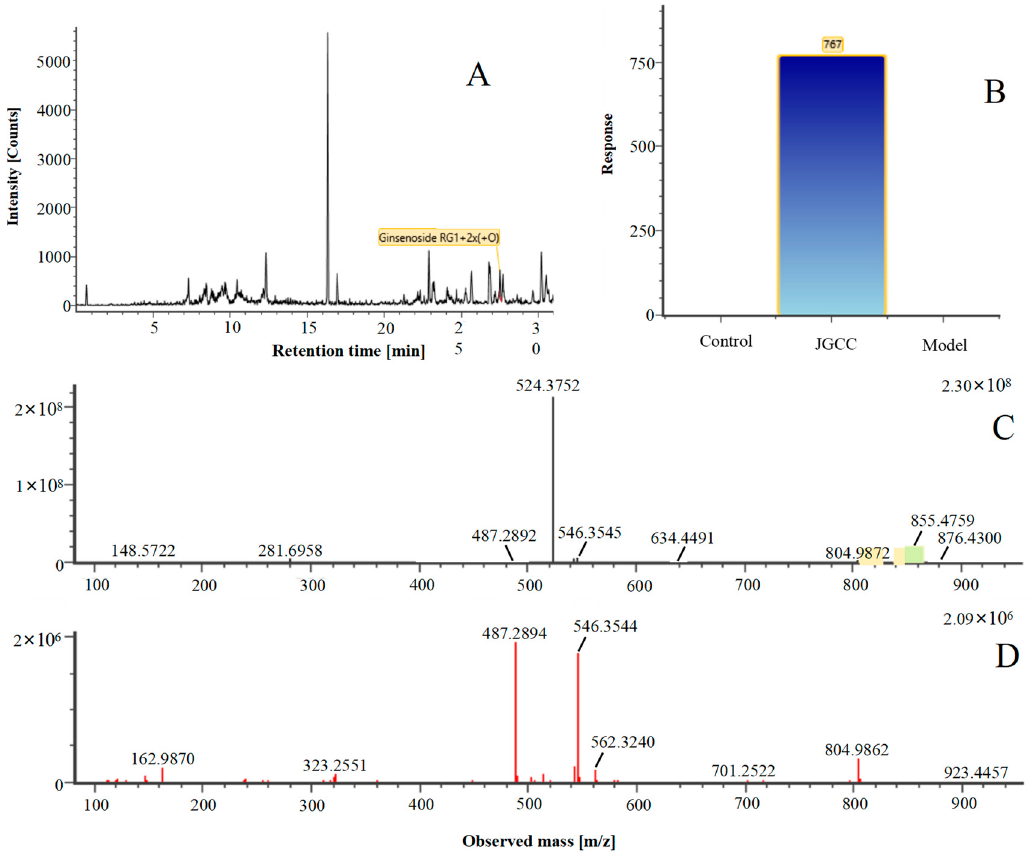
Figure 6. The characterization and identification of the blood component metabolite M 21 in JGCC based on the UNIFI data processing platform. ( A ): chromatographic peak extraction diagram of the metabolite M 21 from Ginsenoside Rg 1 , ( B ): comparison of response values in serum of M 21 for control, model and JGCC group, ( C ): MS/MS information of M 21 under low-energy collision, ( D ): MS/MS information of M 21 under high-energy collision.